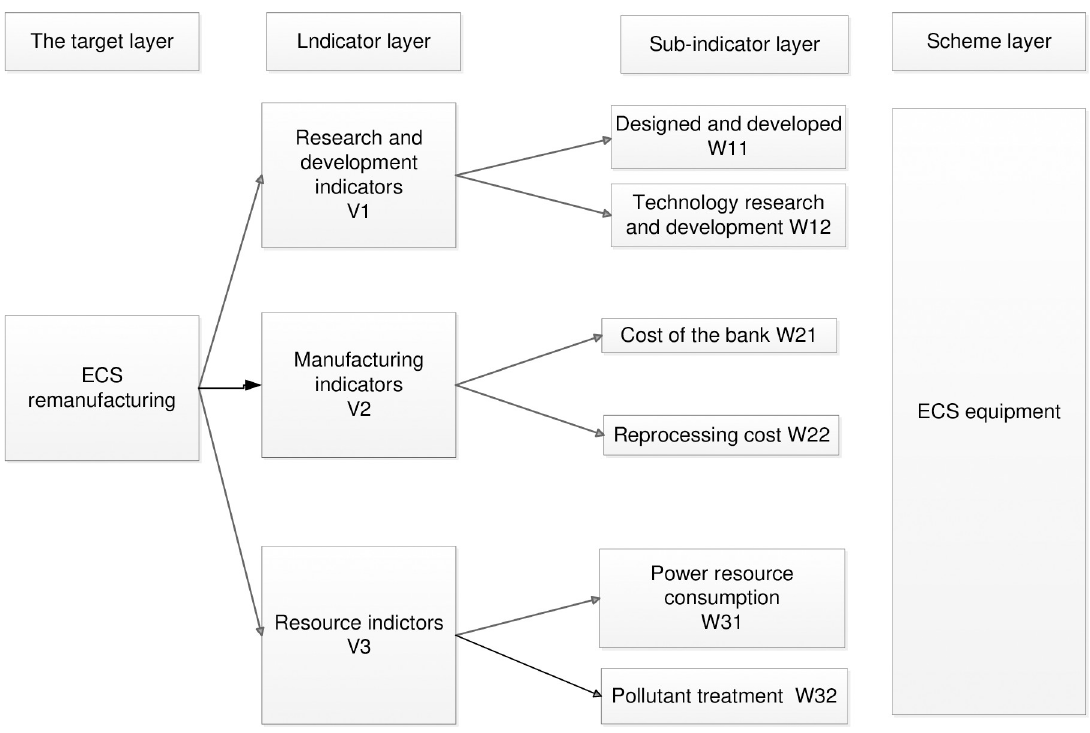
Fig 3. Structural diagram of the analytic hierarchy process.